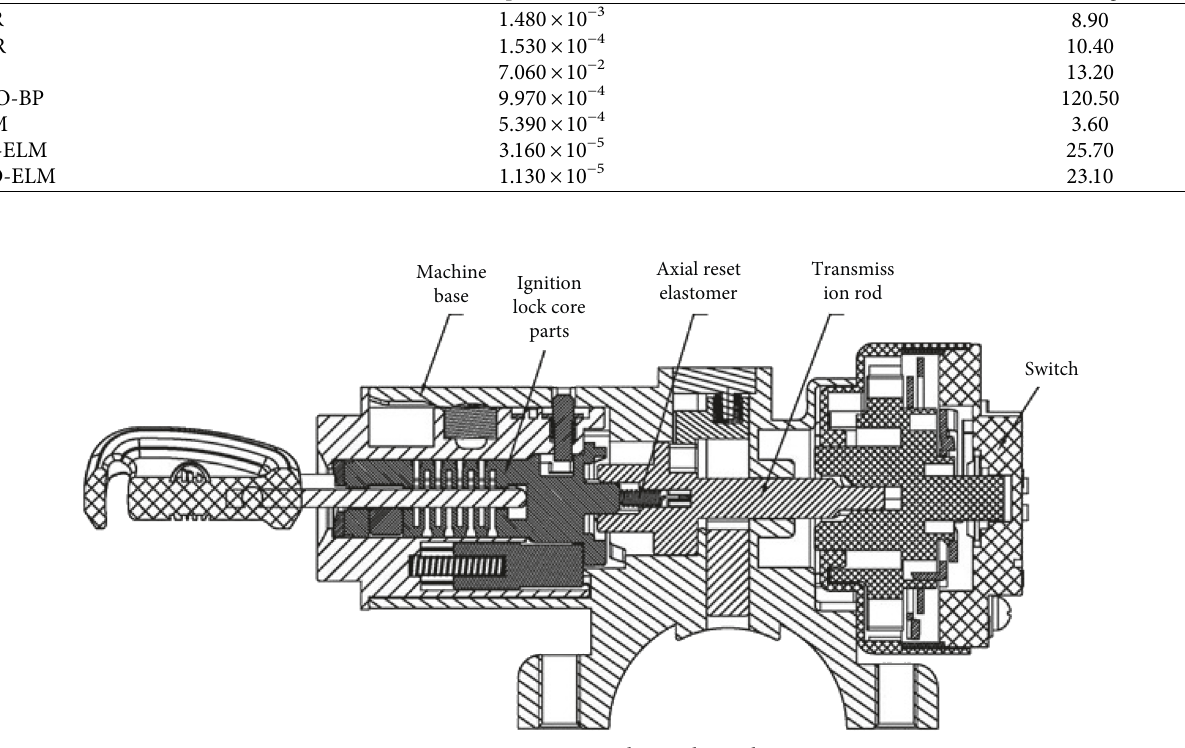
Table 5: Performance comparison between prediction models for auxiliary installation of automotive electrical switches. Algorithm model